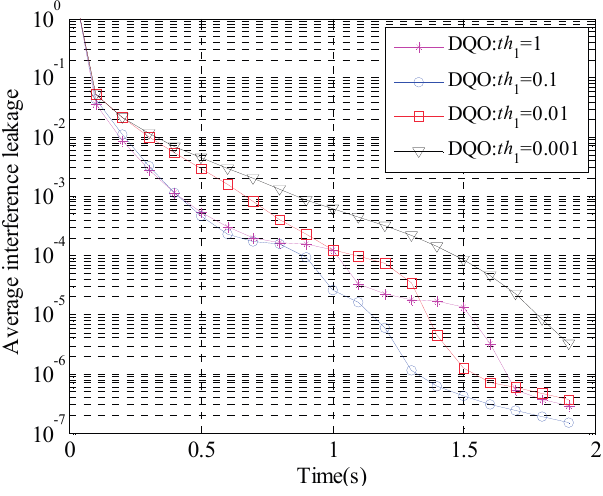
Figure 2. Convergence curves of the average interference leakage of DQO algorithm with th 1 = 1, 0.1, 0.01, and 0.001 in (5 × 5, 2) 4